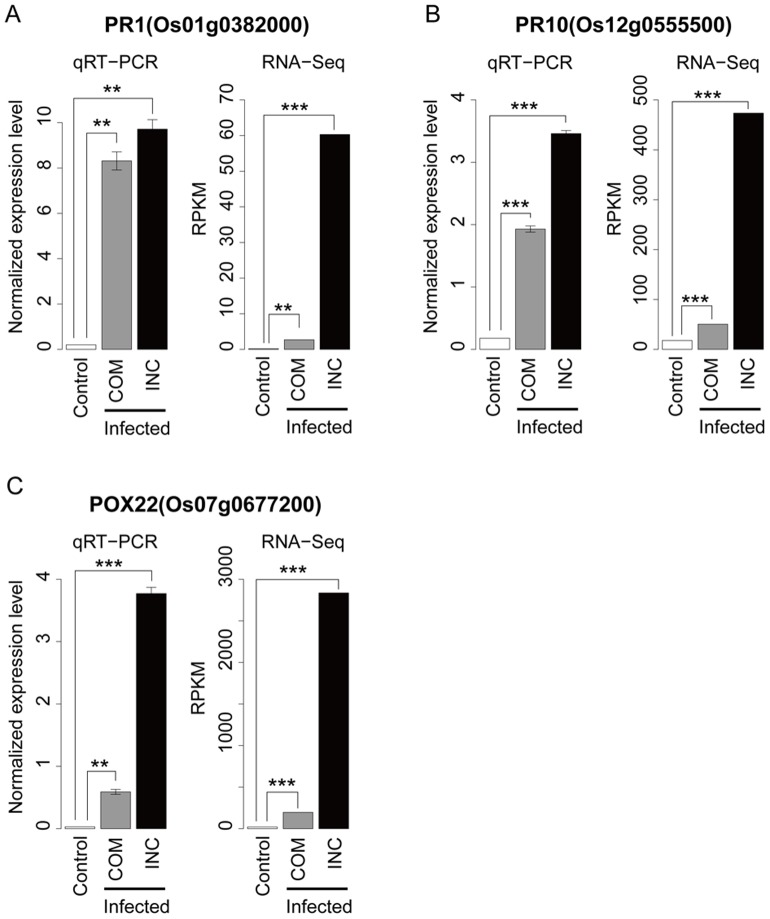
Confirmation of differential expression of known infection-responsive rice genes by qRT-PCR and RNA-Seq.The expression profiles of known infection-responsive rice genes, (A) PR1, (B) PR10 and (C) POX22, were examined by both qRT-PCR and RNA-Seq techniques. For the qRT-PCR data, the mean±standard errors for the three replicates are represented. The statistically significant differential gene expression between the control (Cont) and infected (Inf) samples for the compatible (COM) and incompatible (INC) interactions was tested by the Student's t-test and G-test for qRT-PRC and RNA-Seq, respectively. The asterisks show the statistical significances (*: P<0.05, **: P<0.01 and ***: P<0.001).